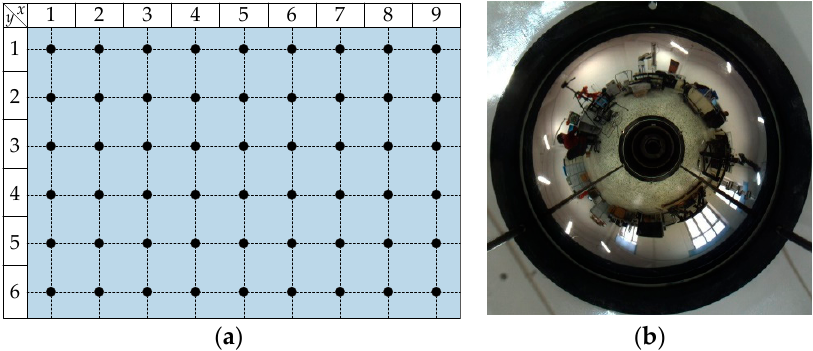
Figure 8. Representative locations and panoramic image sample: ( a ) representative locations, which are denoted as the black solid circles; and ( b ) panoramic image sample, which was captured at Location (8,4).